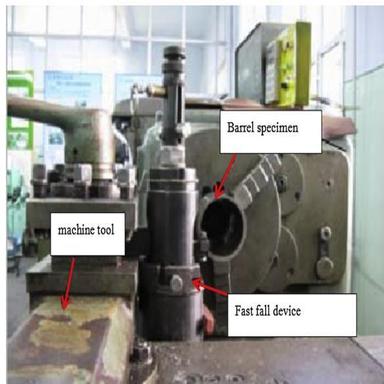
Experimental setup for obtaining a chip root.